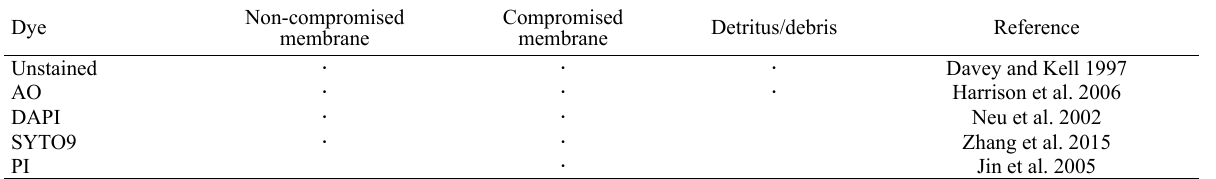
Table S1. – Stain potential to dye compromised and non-compromised cell membranes, and detritus.